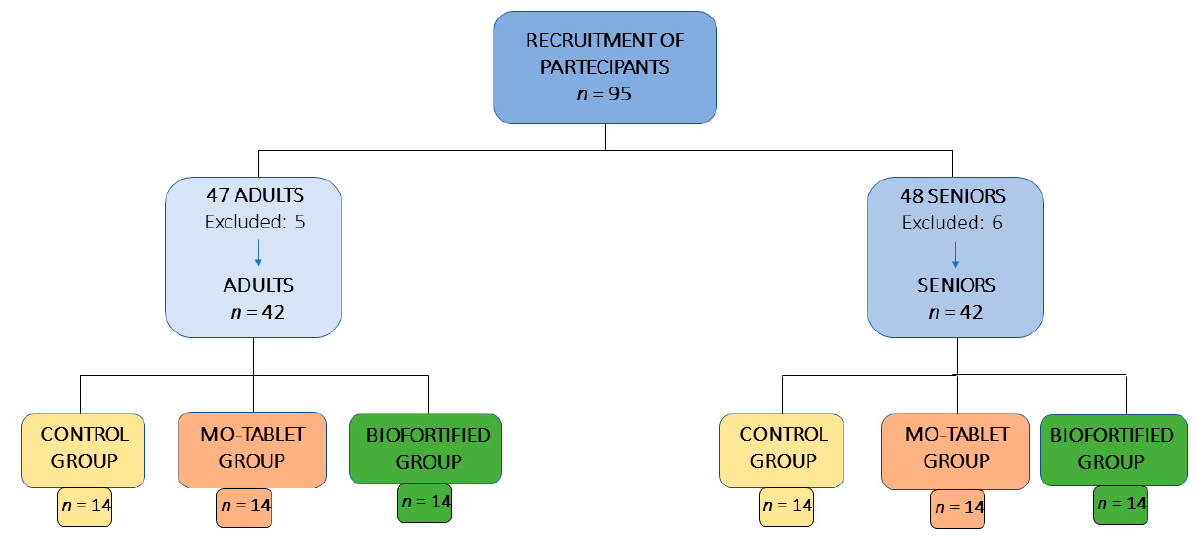
Nutrients 2023 , 15 , 1022 Figure 1. Process of participants’ recruitment in the study.